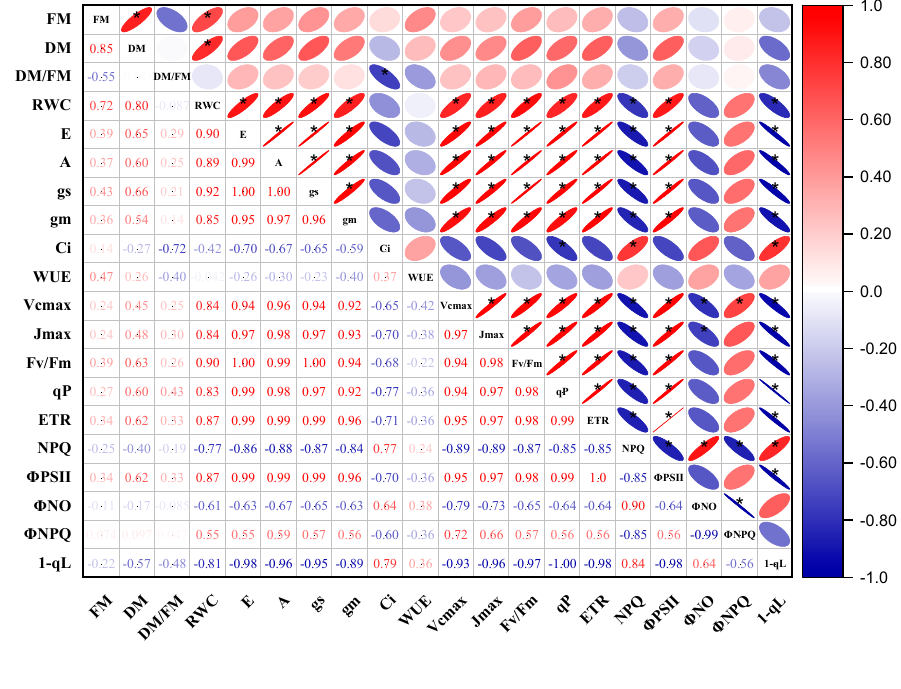
Figure 6. Pearson’s correlation matrix of the changes in biomass, gas exchange, and chlorophyll fluorescence parameters of the two cowpea genotypes under control and waterlogging treatments. Dark color represents strong correlations, and light background color represents weaker correlations. Values close to zero indicate no correlation, and values close to one indicate a strong correlation (positive—red and negative—blue) between two parameters. * Represent correlation coefficient significance levels at p ≤ 0.05. Where FM = fresh mass, DM = dry mass, RWC = relative water content, E = transpiration rate, A = CO 2 assimilation rate, g s = stomatal conductance, C i = intercel- lular CO 2 concentration, WUE = water use efficiency, V cmax = maximum rate of Rubisco carboxy- lation efficiency, J max = maximum rate of photosynthetic electron transport, F v /F m = maximum quantum efficiency of PSII in dark-adapted state, qP = photochemical quenching, ETR = electron transport rate, NPQ = non-photochemical quenching, Φ PSII = actual photochemical efficiency of PSII, Φ Φ NO = quantum yield of non-regulated energy dissipated in PSII, NPQ = quantum yield of regu- lated non-photochemical energy loss in PSII, 1-qL = redox State of Plastoquinone Pool based on the Lake